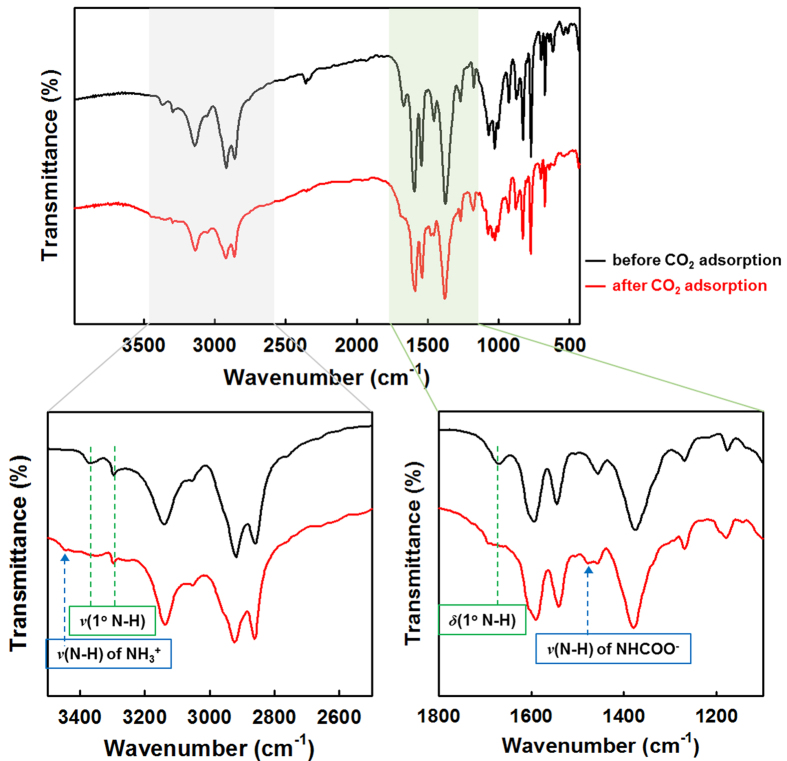
Infrared spectra for MOFNH2:powder before (black) and after (red) adsorbing CO2.